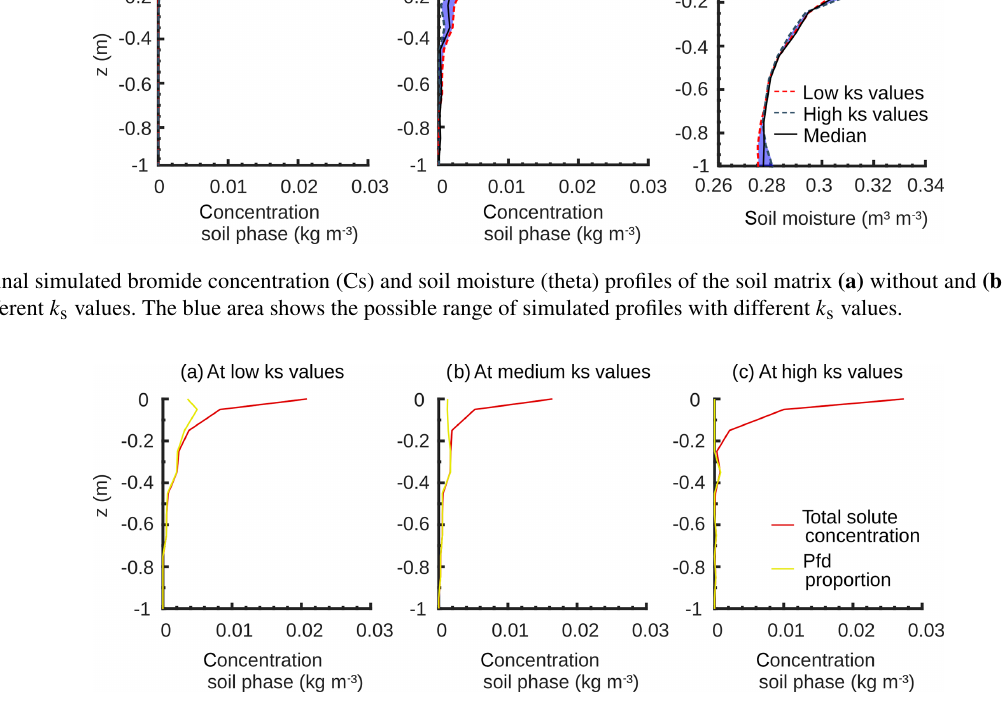
Figure 8. Final bromide concentration profiles at (a) low, (b) medium and (c) high k s values and the proportion of solutes which originate from the